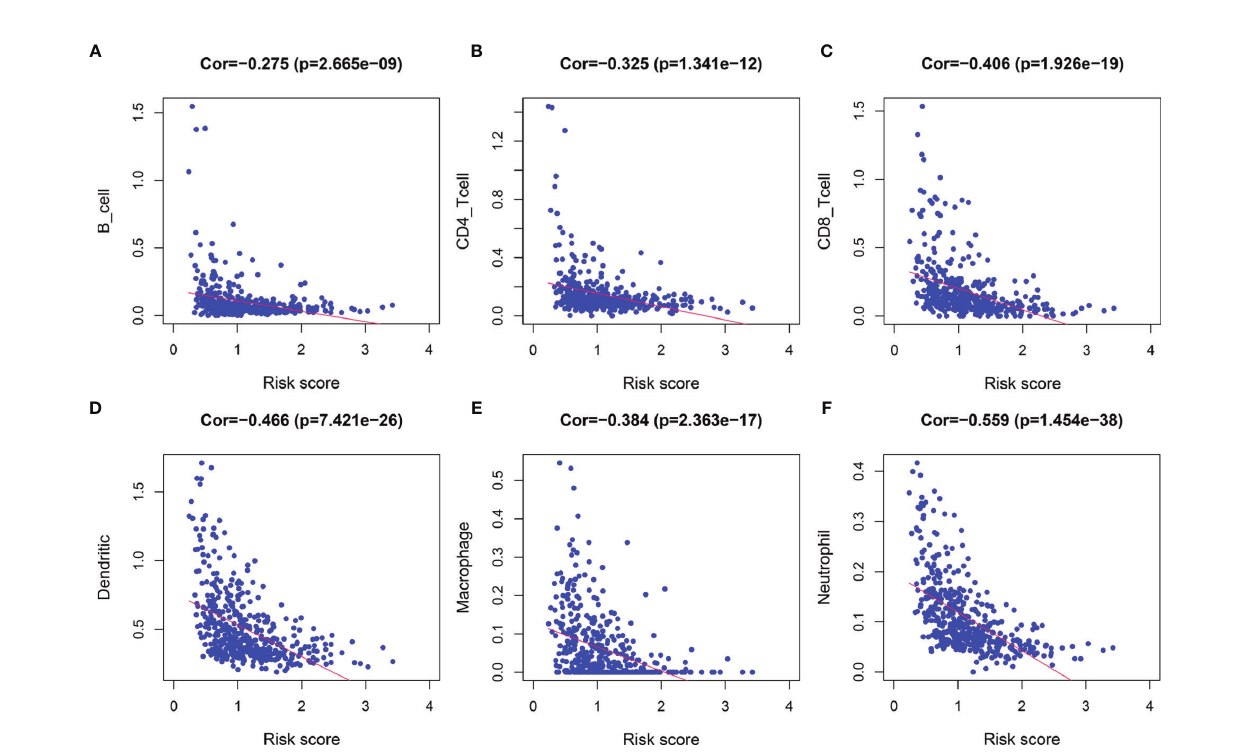
FIGURE 9 | The correlation between the signature and in fi ltration abundances of six immune cell types. (A) B cells, (B) CD4+ T cells, (C) CD8+ T cells, (D) Dendritic cells, (E) Macrophages, and (F)